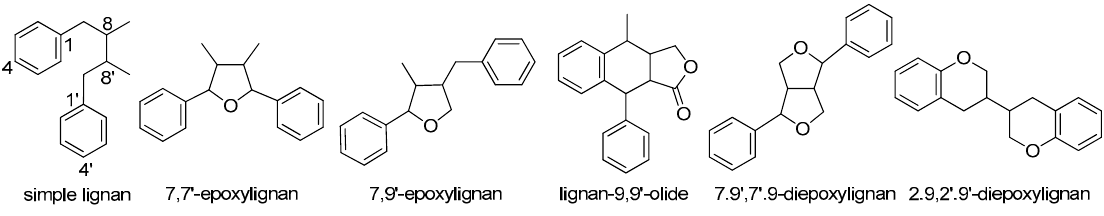
Figure 1. Subtypes of classical lignans.